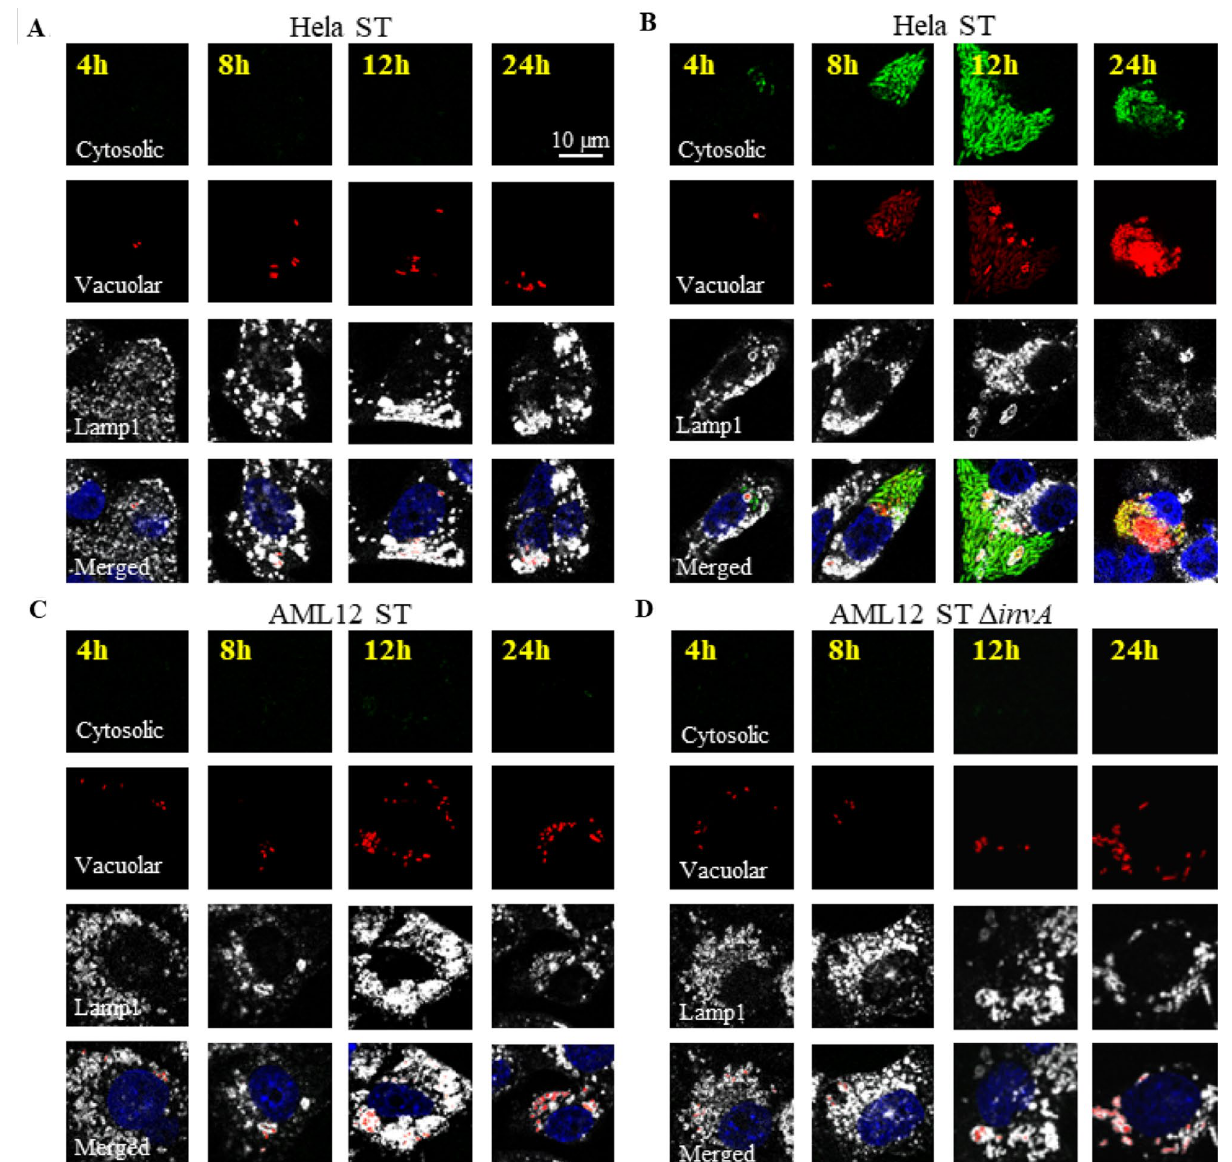
assay, then fixed and stained with mouse Lamp1 or rat Lamp1 antibody, respectively, then revealed with anti- mouse or anti-rat antibody Alexa Fluor 647 (white) imaged at 4, 8, 12, and 24 h pi. ( A – D ) are organized as a first line of images, allowing to potentially observe cytosolic bacteria (green) second line vacuolar and cytosolic bacteria (red), third line Lamp1 staining (white) and fourth line merged image of the first three lines (cytosolic bacteria appeared yellow to green). Imaging was performed using confocal microscopy with a 100 × oil immersion objective (Leica TCS SP8, Germany). Nuclei were counterstained with DAPI (blue) vacuolar bacteria (red) and cytosolic bacteria (green and weakly red = yellow to orange, mainly green due to hyper-replication). Scale bars 10